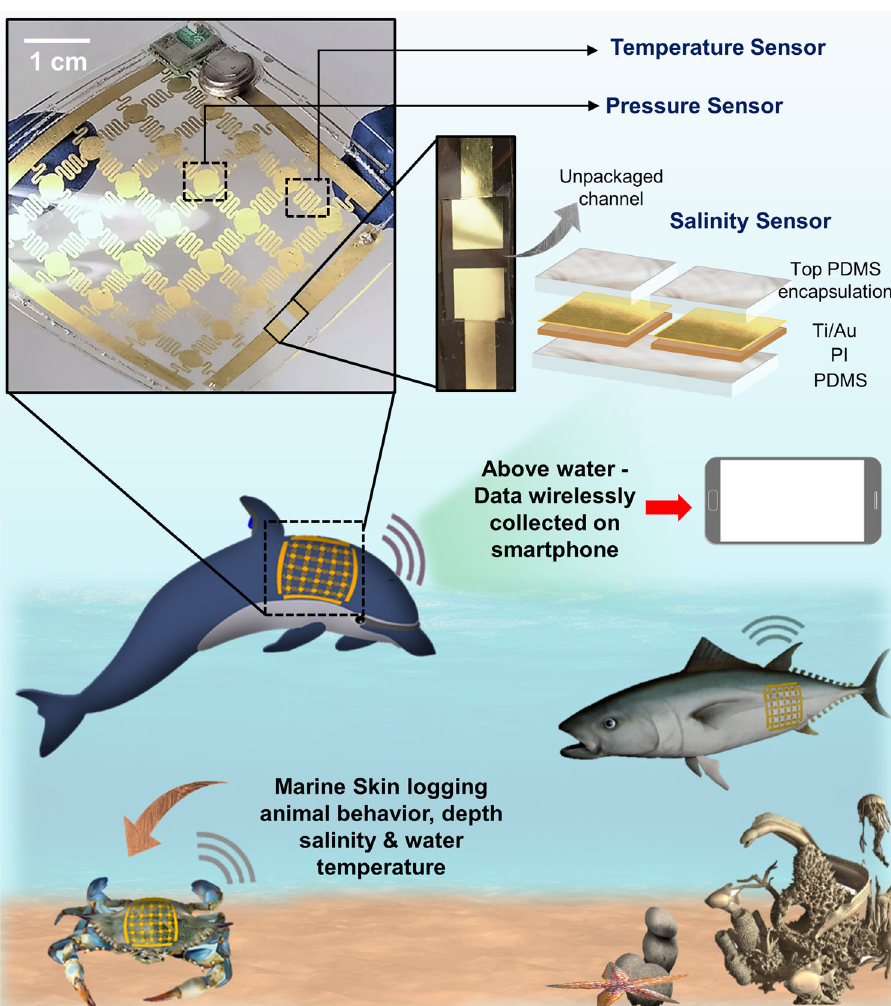
Fig. 1 Marine Skin illustration. Marine species wearing Marine Skin system, for continuous tracking of the marine ecosystem. Outset digital photo depicts the recon fi gurable net-like array design for geometric stretchability and fl exibility of Marine Skin. The waterproofed system continuously logs temperature, pressure, and salinity data from the surrounding environment, to assess ocean health and track animal mobility using marine life as allies. Real-time data is then wirelessly transmitted upon resurfacing of the marine